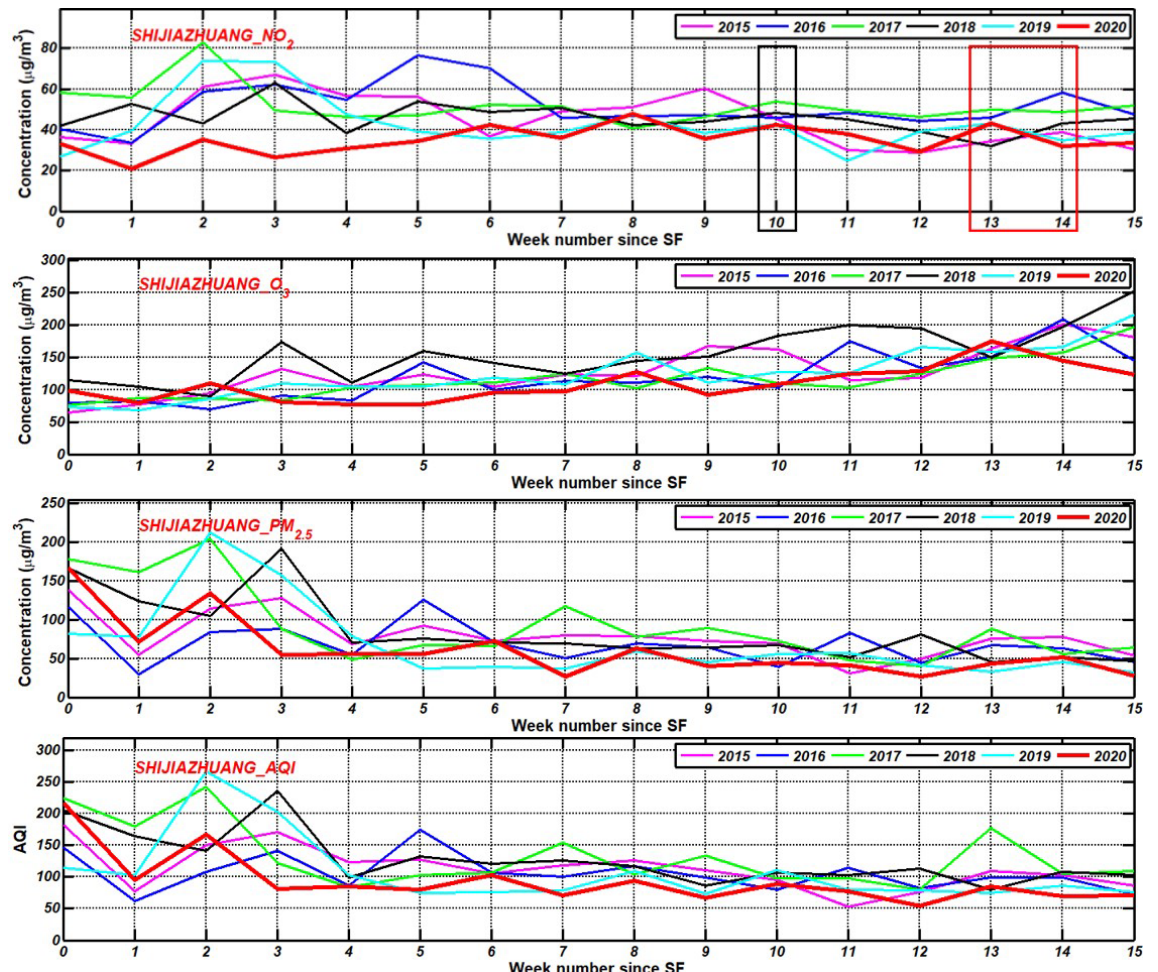
Figure 6. Time series of the concentrations of NO 2 , O 3 and PM 2 . 5 in Shijiazhuang for weeks 0 to 15 starting from the Spring Festival in 2020 (red line), together with time series for these pollutants for the same weeks in 2015–2019. See legend for identification. Rectangles in the NO 2 time series were added for easy identification of the Tomb-Sweeping Festival (4 and 5 April, in week 10; red) and the May festival (1–5 May, in weeks 13–14; black) which are discussed in the text. The Spring Festival date and thus week 0 is determined by the Lunar Calendar, therefore these dates apply only to 2020, and in the other years they may fall in different